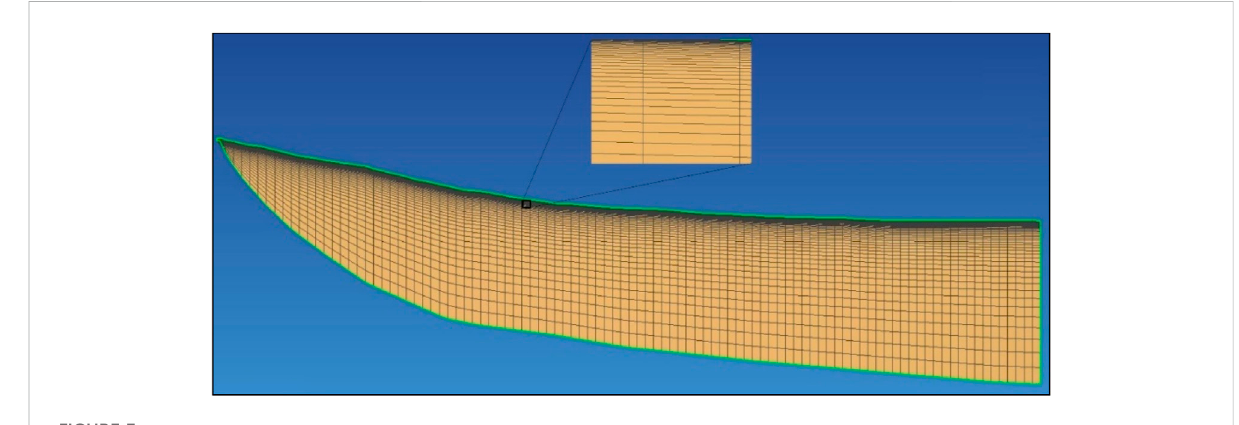
FIGURE 3 The model mesh of the simulation